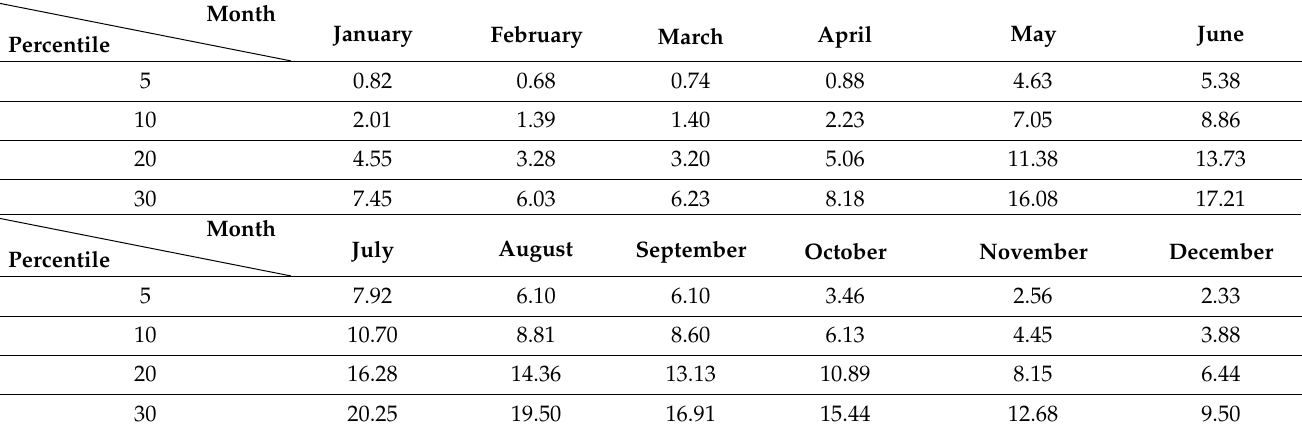
Table 5. Precipitation amounts (mm) corresponding to drought percentiles for the Grassland Region of Australia in different